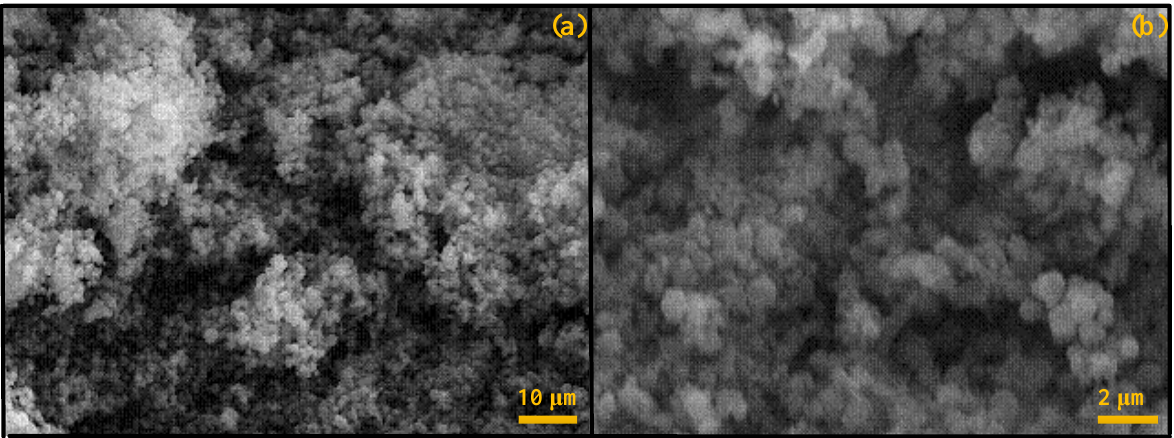
Figure 5. SEM images of the Co-ZIF catalyst. ( a ) fresh catalyst at magnification of 2,000; ( b ) fresh catalyst at magnification of 10,000.